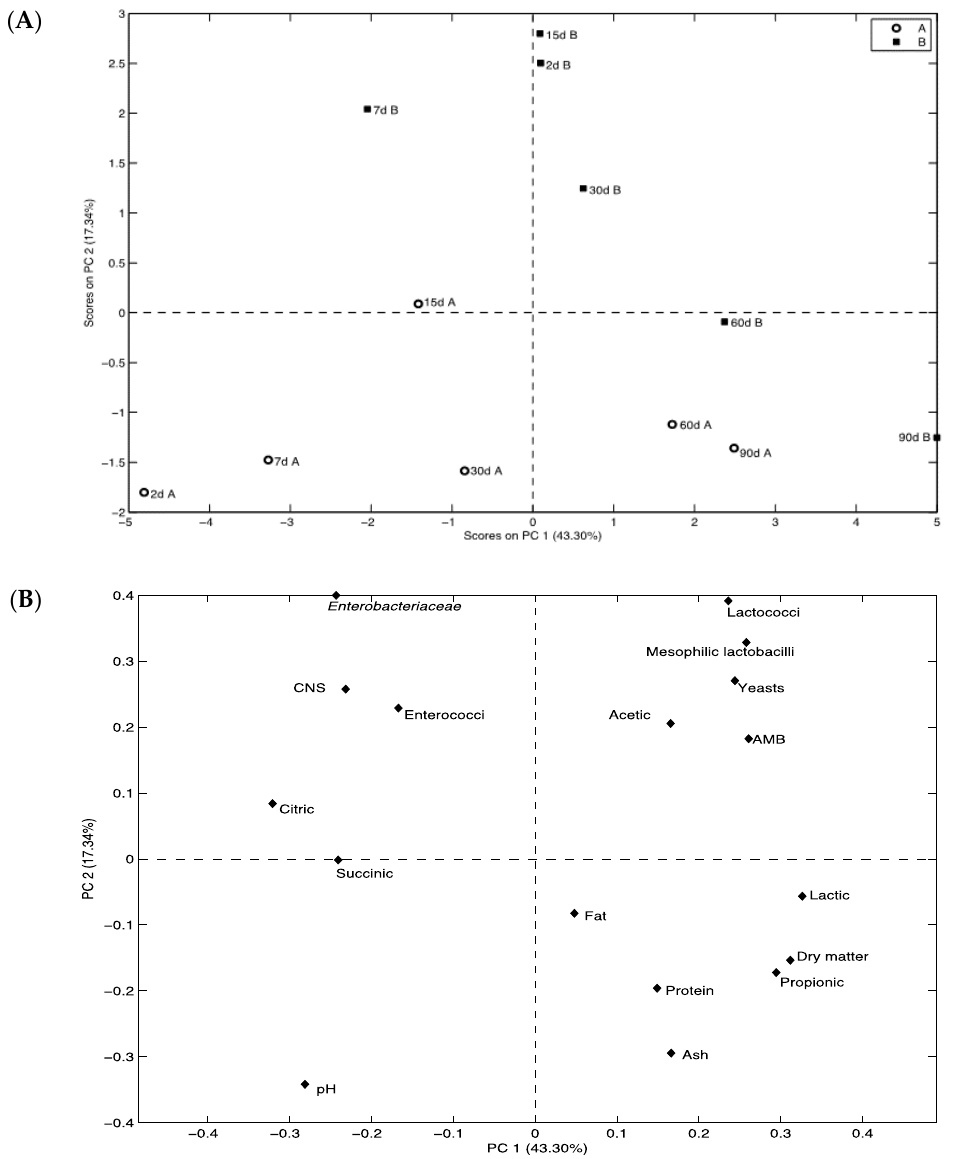
Figure 3. Score plot ( A ) and loading plot ( B ) of the first and second principal components (PCs) after PC analysis encompassing microbiological and physico-chemical parameters.